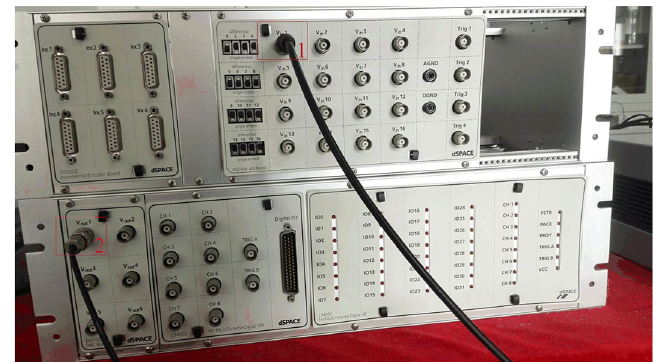
Figure 6. Connection board of